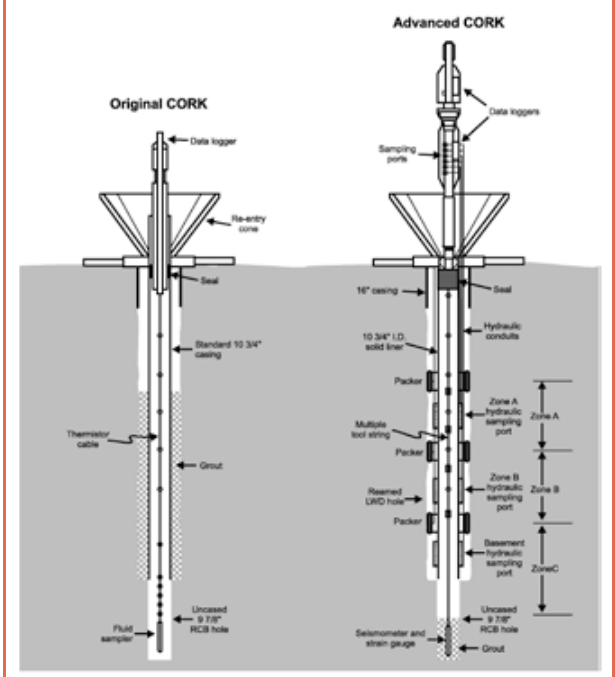
Figure 1. Schematic illustrations of original CORK and advanced CORK plumbing configurations for measuring ocean and formation pressure with sensors at the